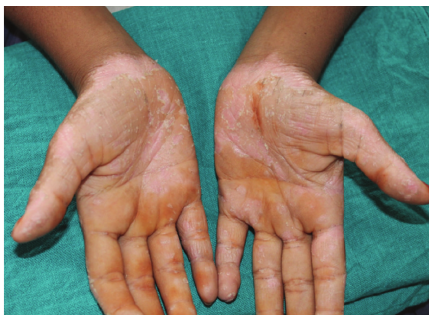
Figure 2: Keratotic plaques which peel off leaving underlying reddish areas over the ventral surface of the skin.